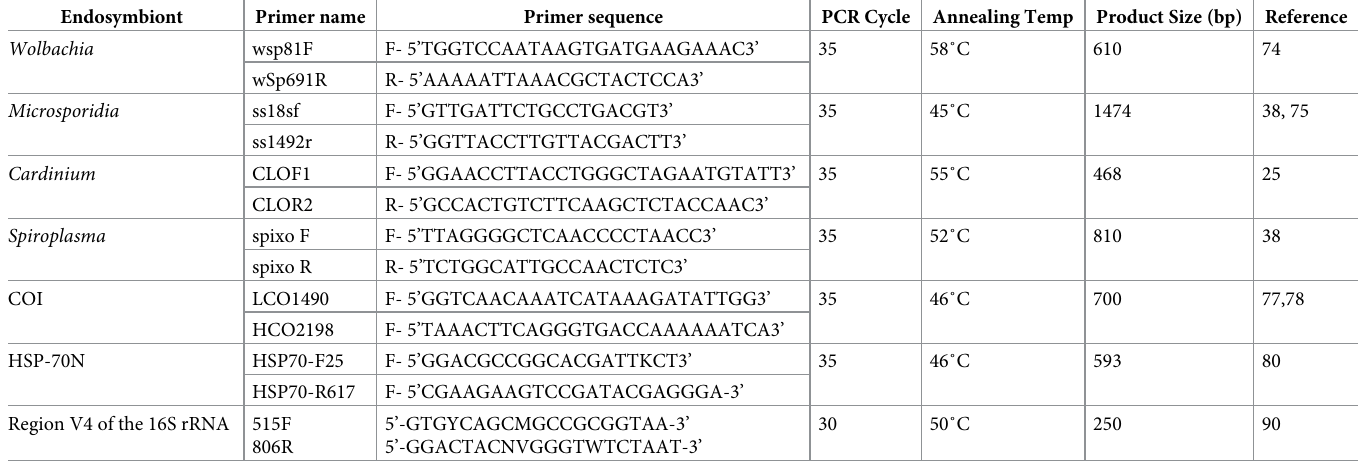
Table 1. Genes and primers used in polymerase chain reaction (PCR) assays to detect reproductive parasites in insect vectors (Phlebotominae Sand flies, Culex , Anopheles ), DNA barcoding for the identification of species, screen of Leishmania infection and microbiota by Illumina MySeq from samples of several locations in